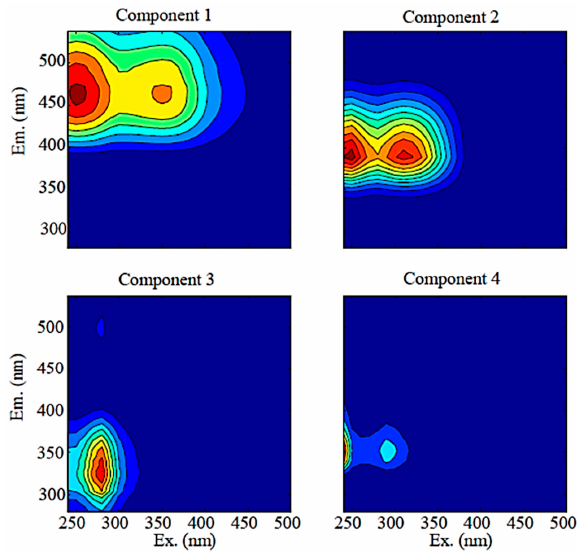
Figure 3. Excitation–emission contour plots of the four DOM fluorescence components (C1–C4) identified with DrEEM toolbox from the Mayfield Creek. Ex. = Excitation; Em. = Emission Percentage biodegradable DOC was in the range of 1.12–9.68% over 5 days and 3.04– 22.66% over 28 days (Figure 4). Among the three sets of incubations, the 29 November 2016 sample had higher %BDOC (22.66 ± 2.17% over 28 days) than the samples from 1 October 2015 (3.04 ± 0.30%) and 26 April 2016 (6.91 ± 3.63%). Among the four fluorescence components, changes in C1 and C2 fluorescence were within ±20% for all samples over 5- day and 28-day incubations, which were much lower than percentage changes in C3 and C4. Both removal and production were observed for C3 and C4. C3 changed by − 53% to +48% over 5 days and − 286% to +64% over 28 days, and C4 changed by ∞ to +32% over 5 days and ∞ to +38% over 28 days (negative values indicate production and positive values in- dicate removal, and ∞ indicates that the initial value was 0).